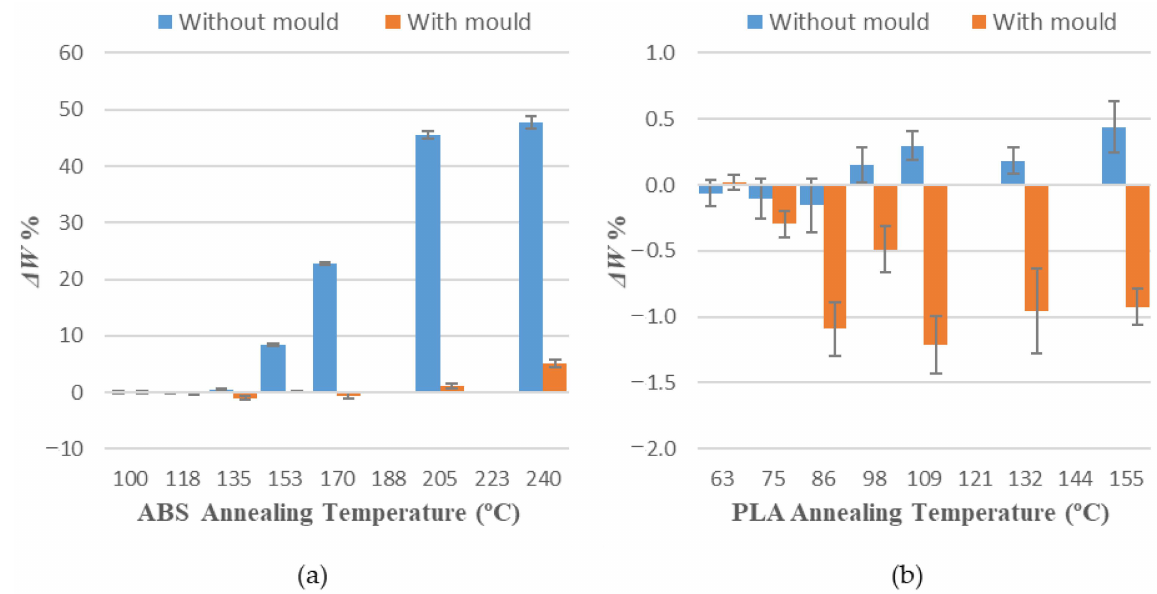
Figure 6. Width variations vs. annealing temperature: ( a ) ABS; ( b )